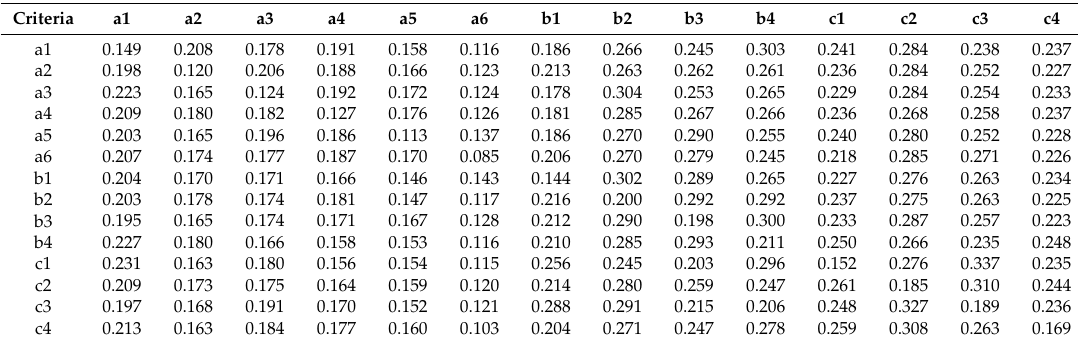
Table 12. Normalized total criteria relationship matrix.